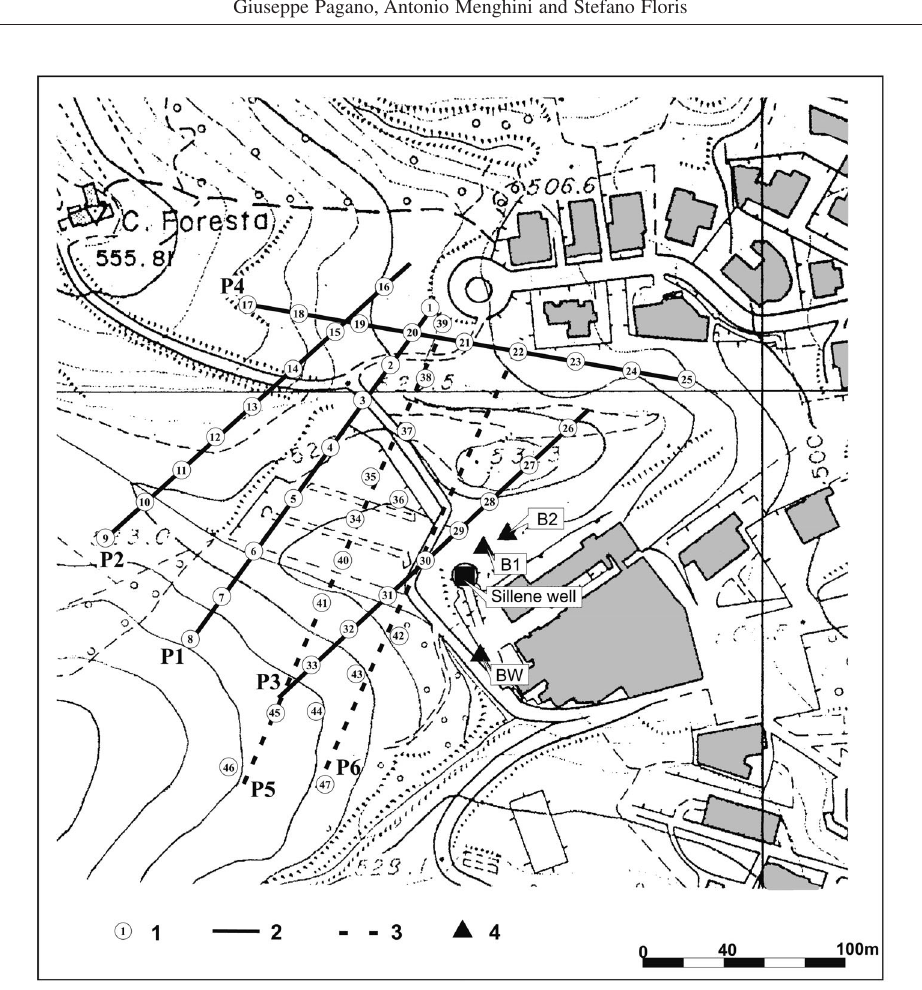
Fig. 3. Location map of geophysical prospections: 1 = TEM sounding; 2 = electrical and coincident electromagnetic profile; 3 = electromagnetic profile; 4 = borehole (BW = Benelli well; B1 = borehole n. 1; B2 = borehole n.